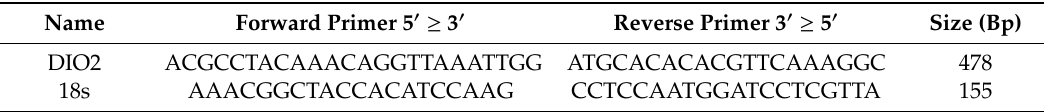
Table 1. Sequences of the primers used (Integrated DNA Technologies, Coralville, Iowa,